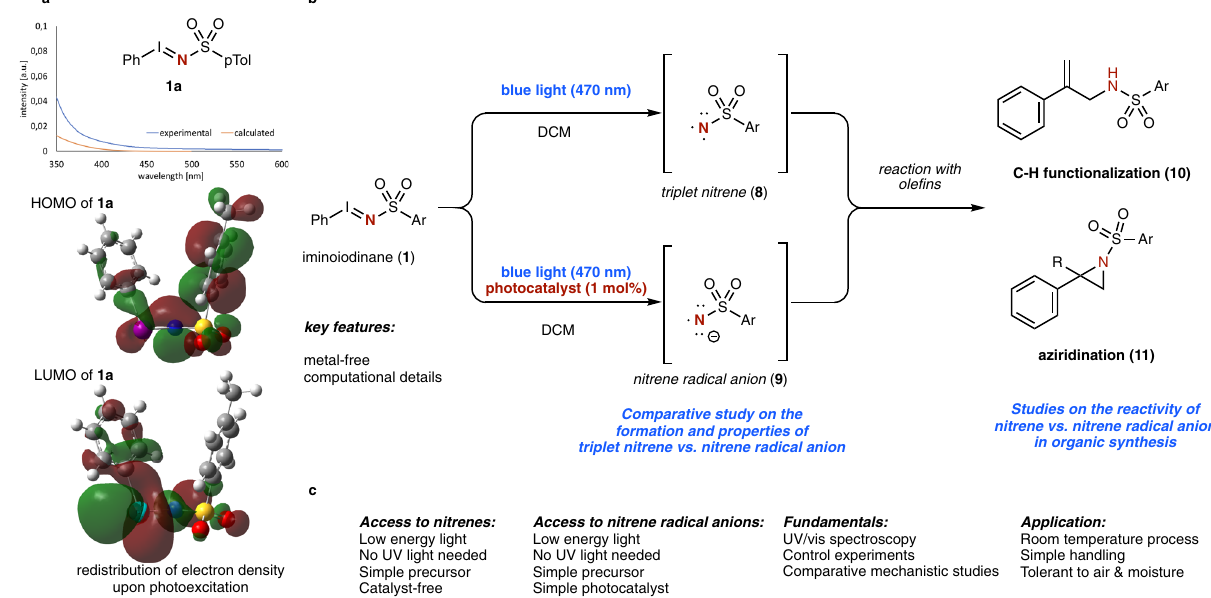
Fig. 2 Photochemical amination reactions with nitrenes. a Photochemical properties of iminoiodinane 1a and computed HOMO and LUMO. b Comparative study of nitrene vs. nitrene radical anions. c Key features of this